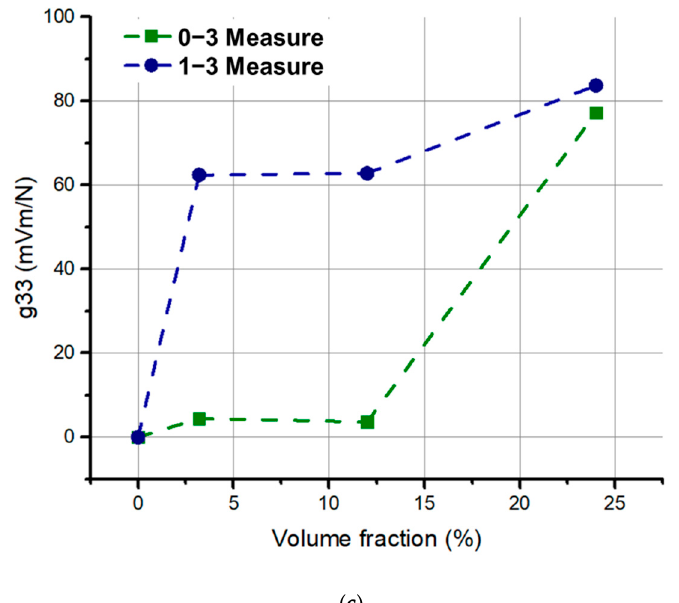
Figure 5. ( a ) Dielectric permittivity, ( b ) piezoelectric charge coefficient, and ( c ) piezoelectric voltage coefficient of 0–3 and 1–3 PZT/PDMS as a function of filler volume content. Comparison between experiment and analytical models was showed in Figure 5a,b.